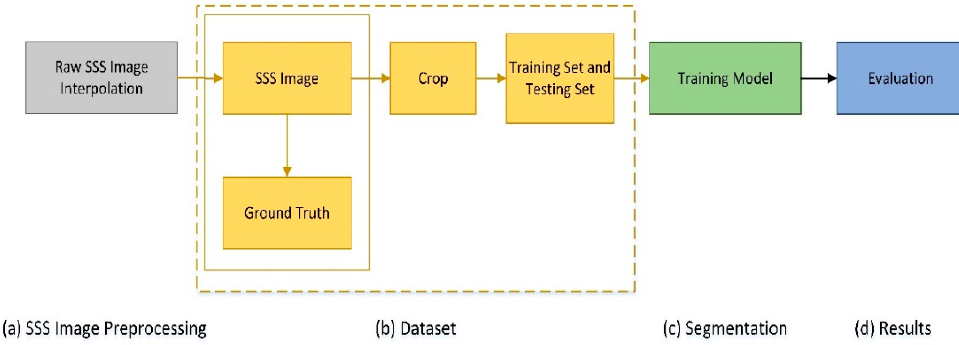
Figure 3. The experimental scheme of our proposed SSS image segmentation method.